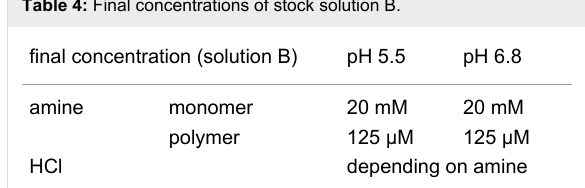
Table 4: Final concentrations of stock solution B.